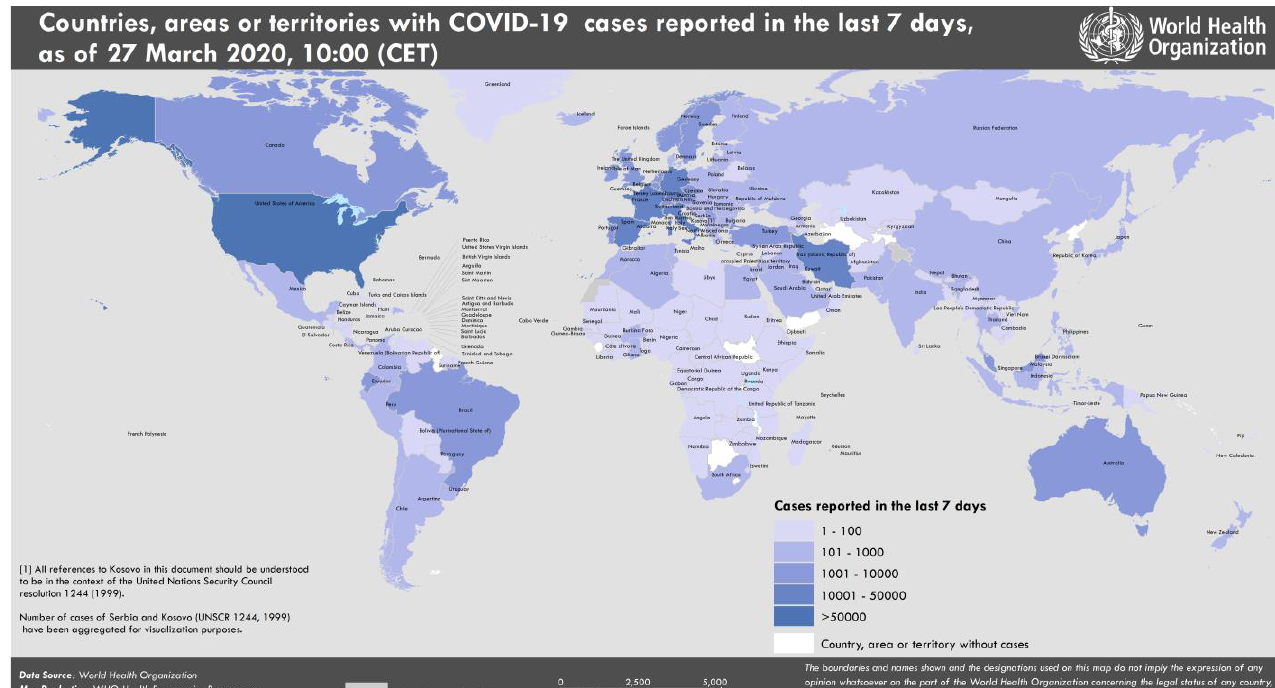
Figure 1. Countries, territories or areas with reported confirmed cases of COVID-19, 27 March